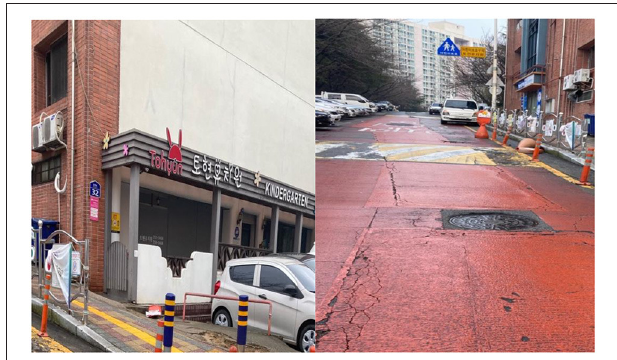
FIGURE 1 | Spot measurement around kindergarten and from the underground transmission line (UGTL) to